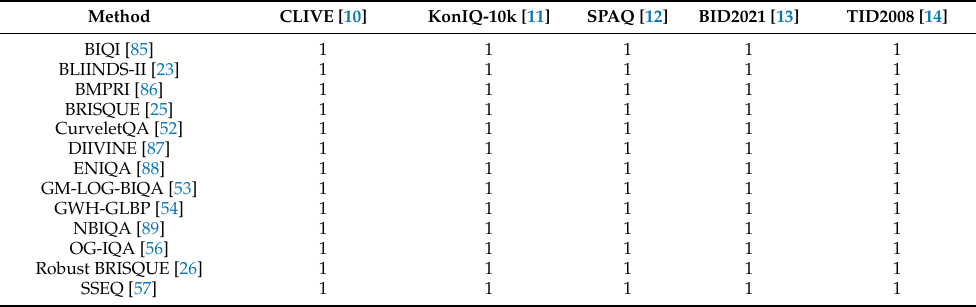
Table 9. Results of the two-sided Wilcoxon rank sum significance tests on CLIVE [10], KonIQ- 10k [11], SPAQ [12], BID2021 [13], and TID2008 [14]. The symbol ’1’ denotes that SGL-IQA provided significantly better results than the method represented in the row on the database represented in the column.